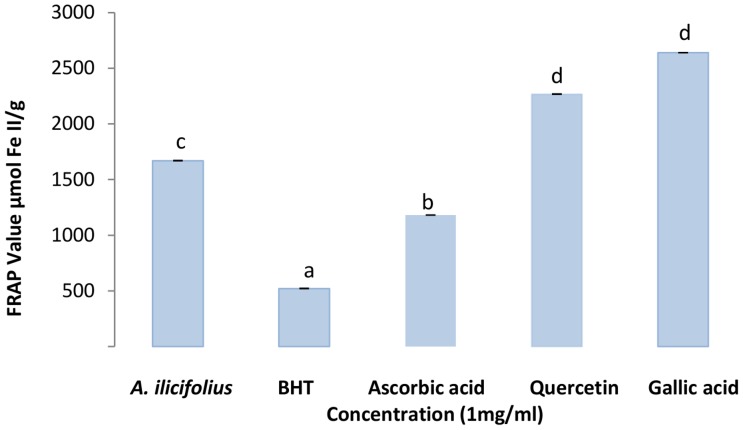
Ferric reducing activity of A. ilicifolius extract.All values are expressed as mean ± SEM. Mean with different letters indicate significantly different values P<0.05. BHT; Butylatedhydroxyl toluene.